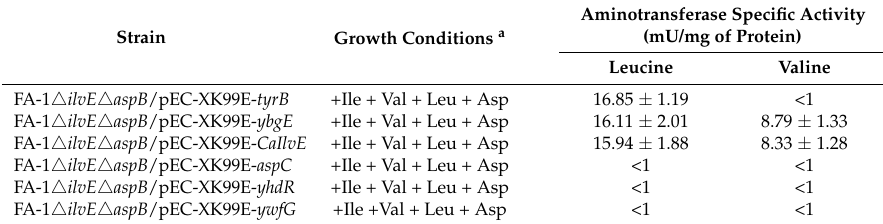
Table 3. Specific activities of transamination enzymes with leucine and valine as